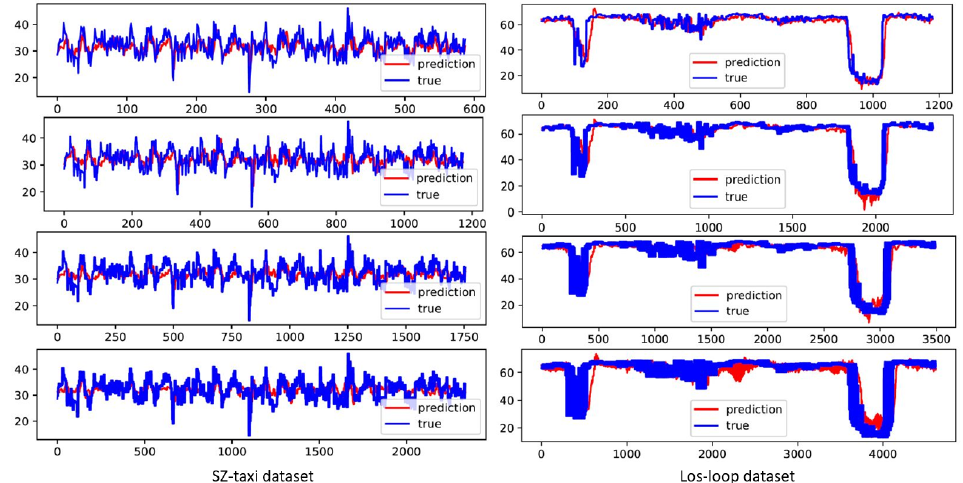
Figure 3. MHSA–GCN traffic prediction display compared to the true values for 15, 30, 45, and 60 min from top to bottom on both SZ-taxi and Los-loop datasets.